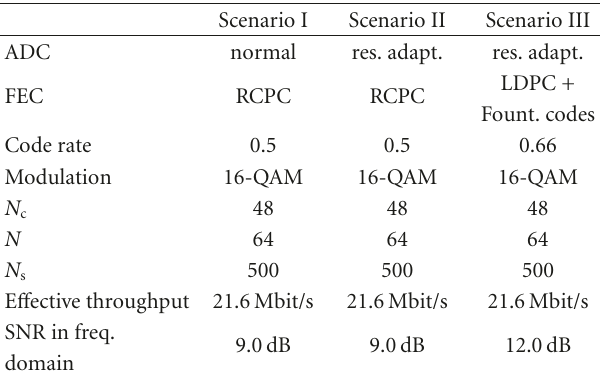
Figure 8: Power consumption defined in (10) versus the number of lost subcarriers for a Fountain code with a packet size of 168 bits. The dot points are with perfect channel knowledge and the circle points are without perfect channel knowledge. Table 1: System setup comparison for three scenarios ( N c : the number of data carriers, N : the number of subcarriers, N s : the number of symbols per MAC